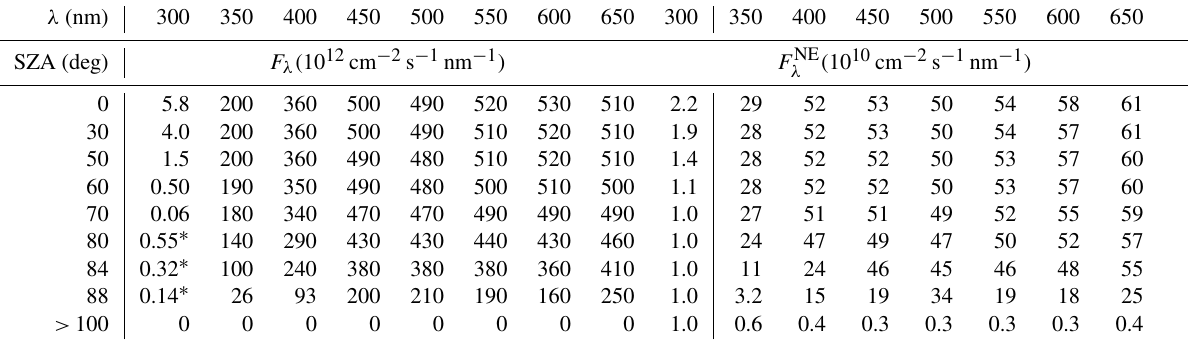
Table 4. Downward clear-sky spectral actinic flux densities F λ from radiative transfer calculations for selected wavelengths and solar zenith angles for an altitude of 15km and an ozone column of 300DU (left) and simulated noise-equivalent actinic flux densities F NE 62001 for a maximum 300ms integration time (right). The entry SZA > 100 ◦ indicates dark conditions.